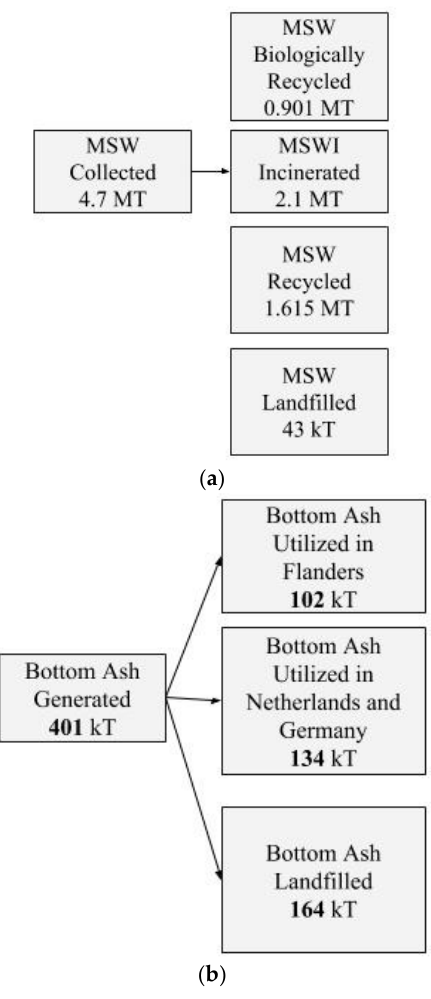
Figure 2. ( a ) Quantity of MSW generated and that composted, incinerated, recycled and landfilled in Belgium in 2015 [18]; ( b ) mass balance of bottom ash residue generated in Flanders in 2013 cf. [18].